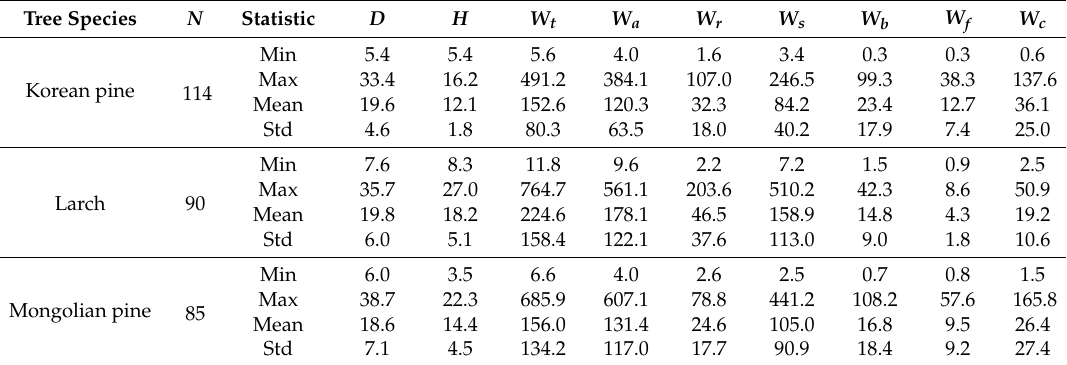
Table 2. Descriptive statistics of main variables of sample